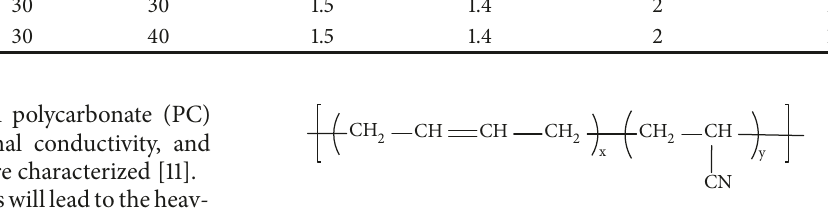
Figure 1: Molecular structural formula of